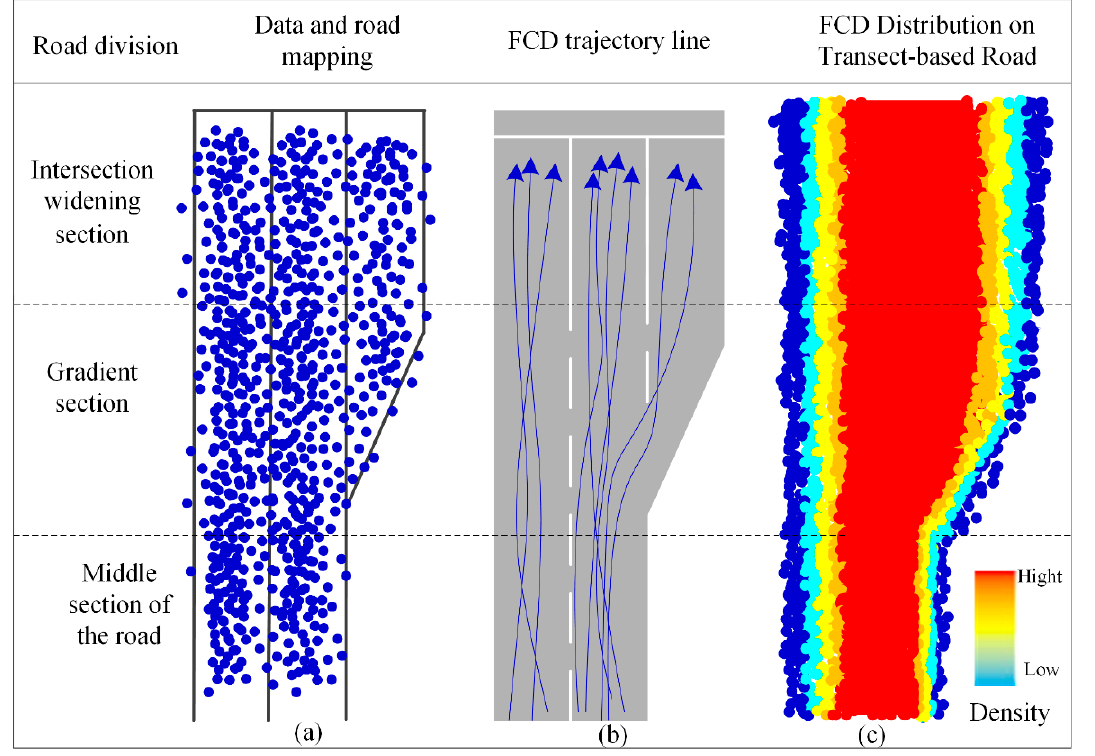
Figure 2. FCD spatial distribution diagram ( a ) data and road mapping; ( b ) FCD trajectory line; ( c ) FCD distribution on transect-based road.